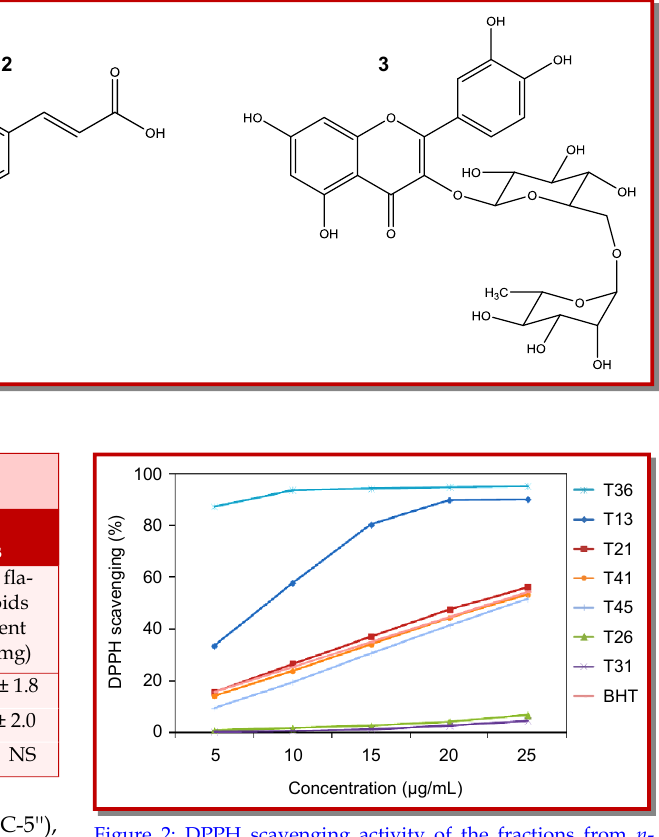
Figure 2: DPPH scavenging activity of the fractions from n - buanol extract at tested